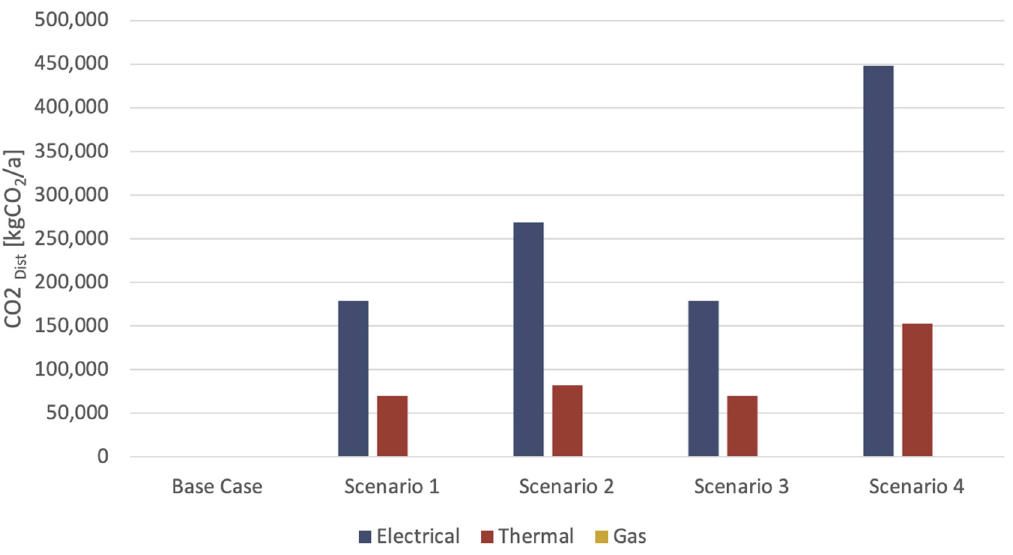
Figure 9. CO 2 equivalent savings (CO2 Dist ) for the Base Case and Scenarios 1–4.